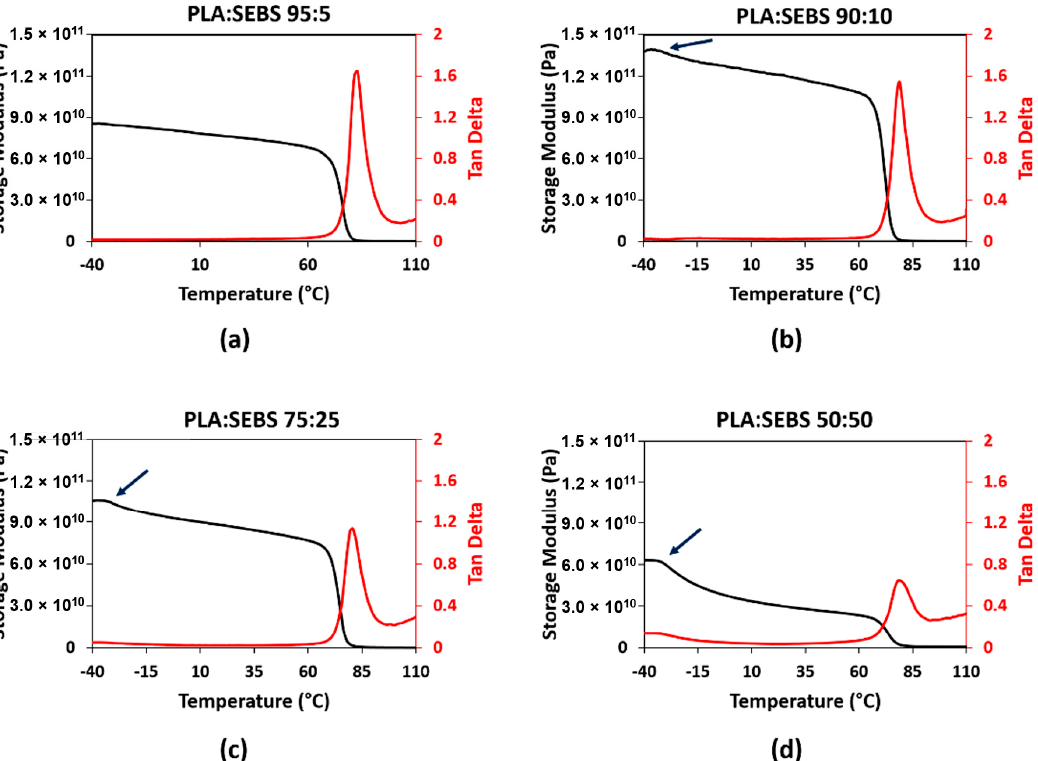
Figure 5. DMA curves for the PLA:SEBS blend system where ( a – d ) correspond to 5, 10, 25, and 50% by weight SEBS, respectively.